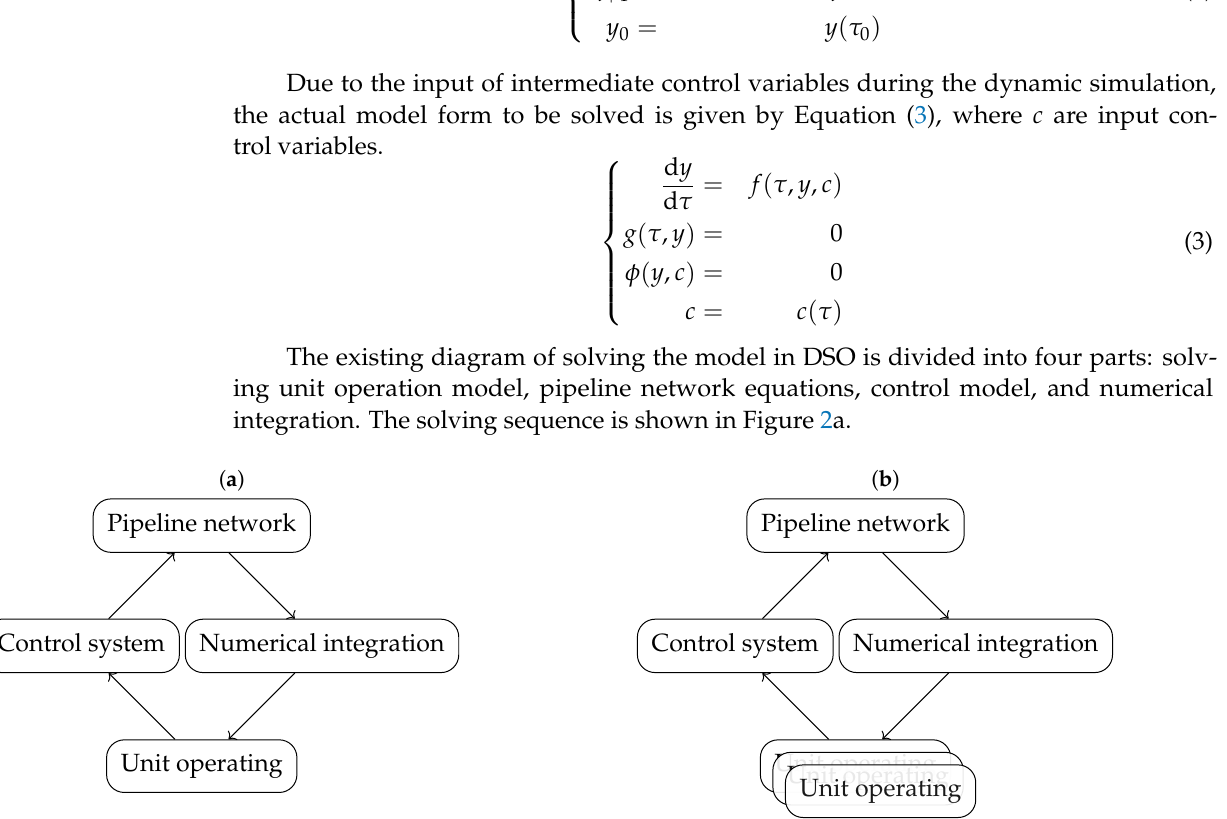
Figure 2. The diagram of solving the model in DSO. ( a ) Conventional serial sequence. ( b ) Parallel